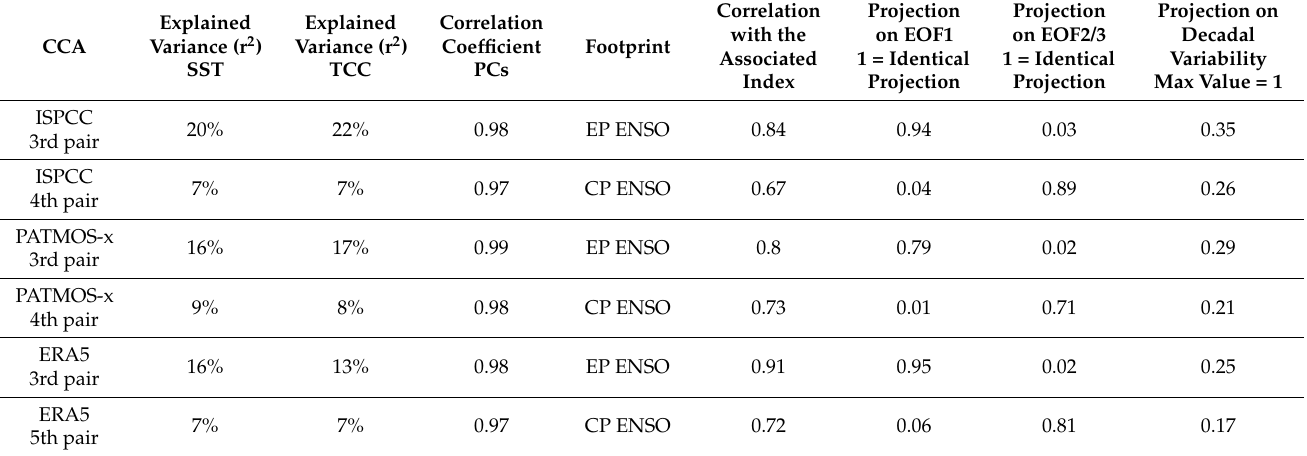
Table 1. The variances explained by the EP ENSO and the CP ENSO SST/TCC patterns from ISPCC (Figure 2) and PATMOS-x (Figure 3) satellite observations and ERA5 reanalysis (Figure